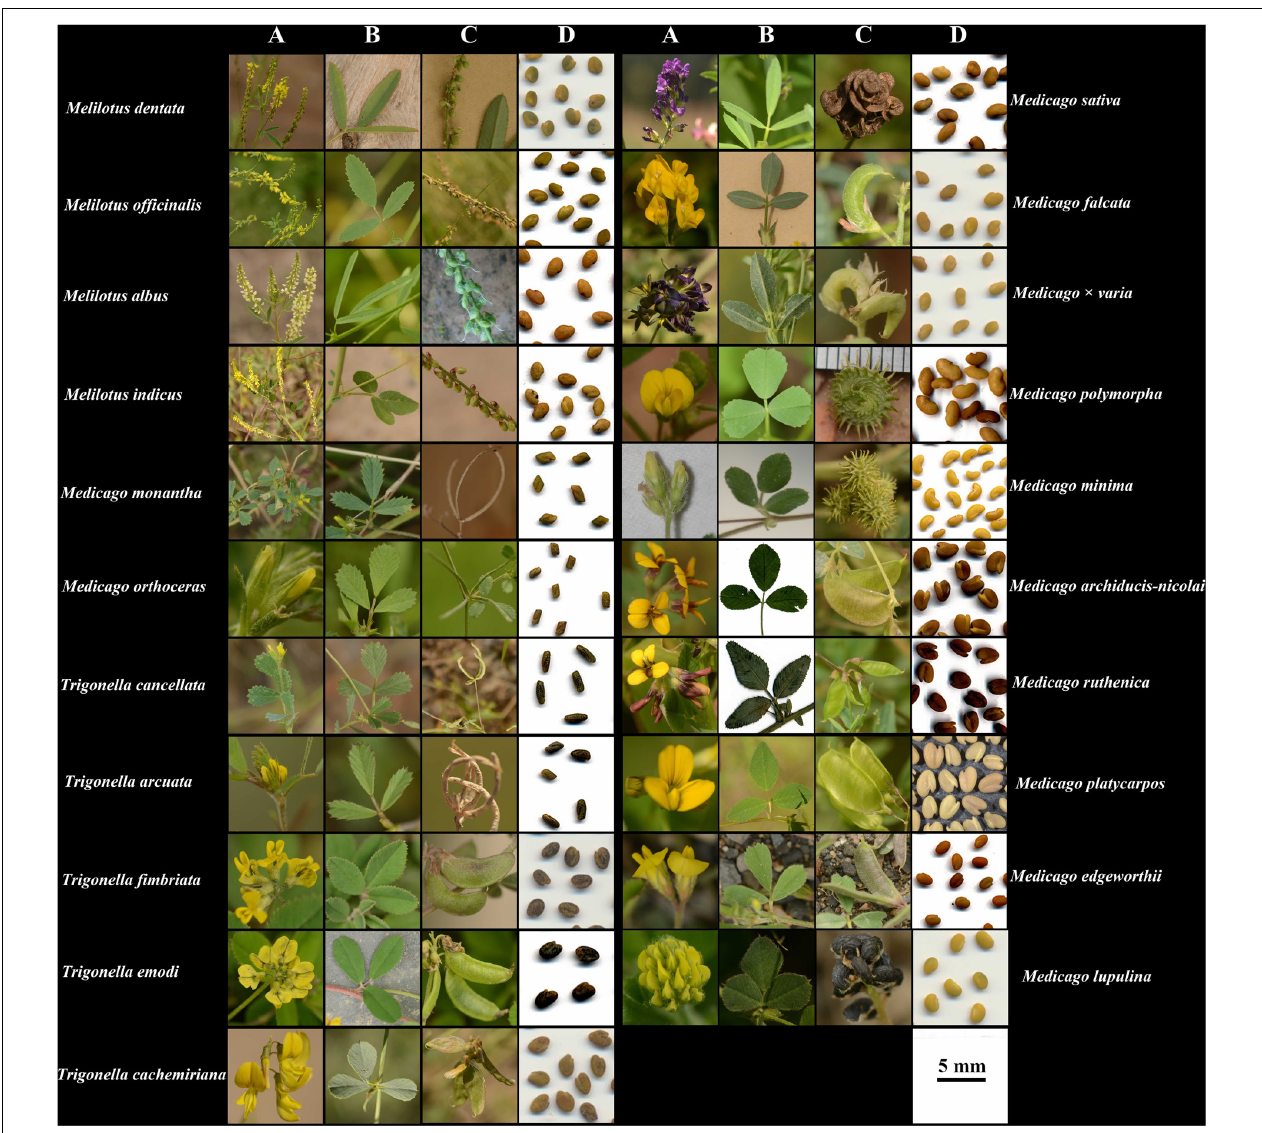
FIGURE 1 | Photos of flowers (A) , leaves (B) , pods (C) , and seeds (D) of the 21 species analyzed in this study. All photos were taken by JC.